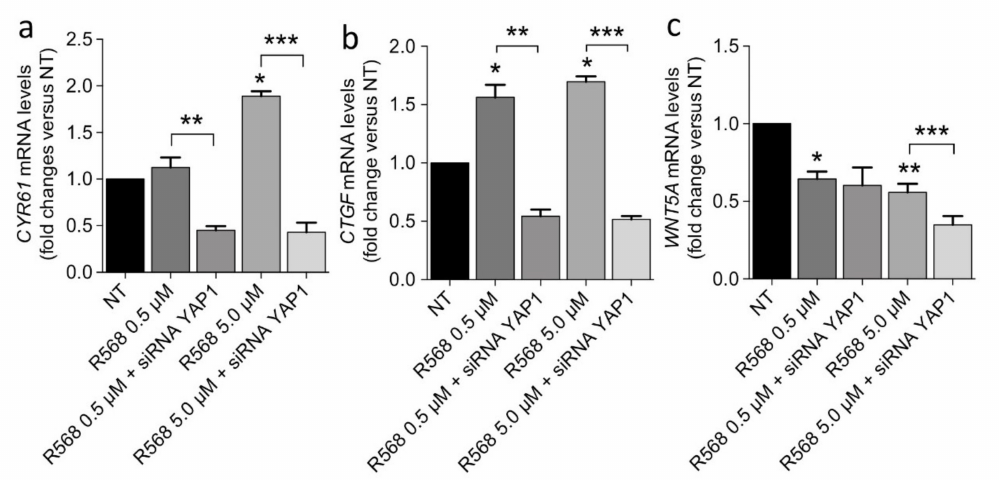
Figure 7. CASR-YAP1 signaling modulation in the CASR-HEK293A cell model. CASR-HEK293A cultures were transiently silenced with a YAP1- or a mock-siRNA and then treated with R568. Gene expression of the indicated transcripts was analyzed by qPCR. p -values are from one-way ANOVA and are as follows: CYR61 (panel a ): * p = 0.001 vs. NT; ** p = 0.012; *** p = 0.0001; CTGF (panel b ): * p = 0.001 vs. NT; ** p = 0.031; *** p = 0.0001; WNT5A (panel c ): * p = 0.015; ** p = 0.0002 vs. NT; ***, p = 0.01. Gene expression levels are presented as fold change with respect untreated conditions; data are mean ± SEM ( n =